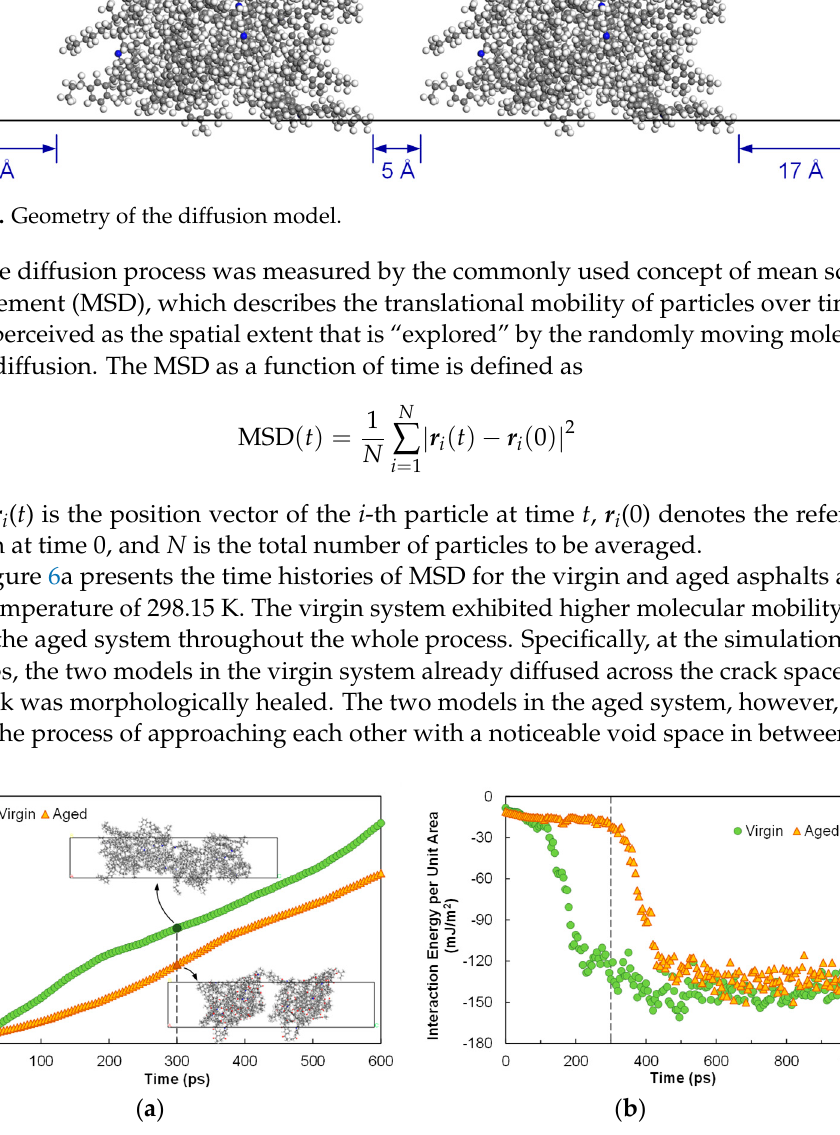
Figure 6. Comparison of the diffusion processes at the temperature of 298.15 K via the time histories of ( a ) MSD and ( b ) interaction energy (negative energy values indicating attractive interactions).